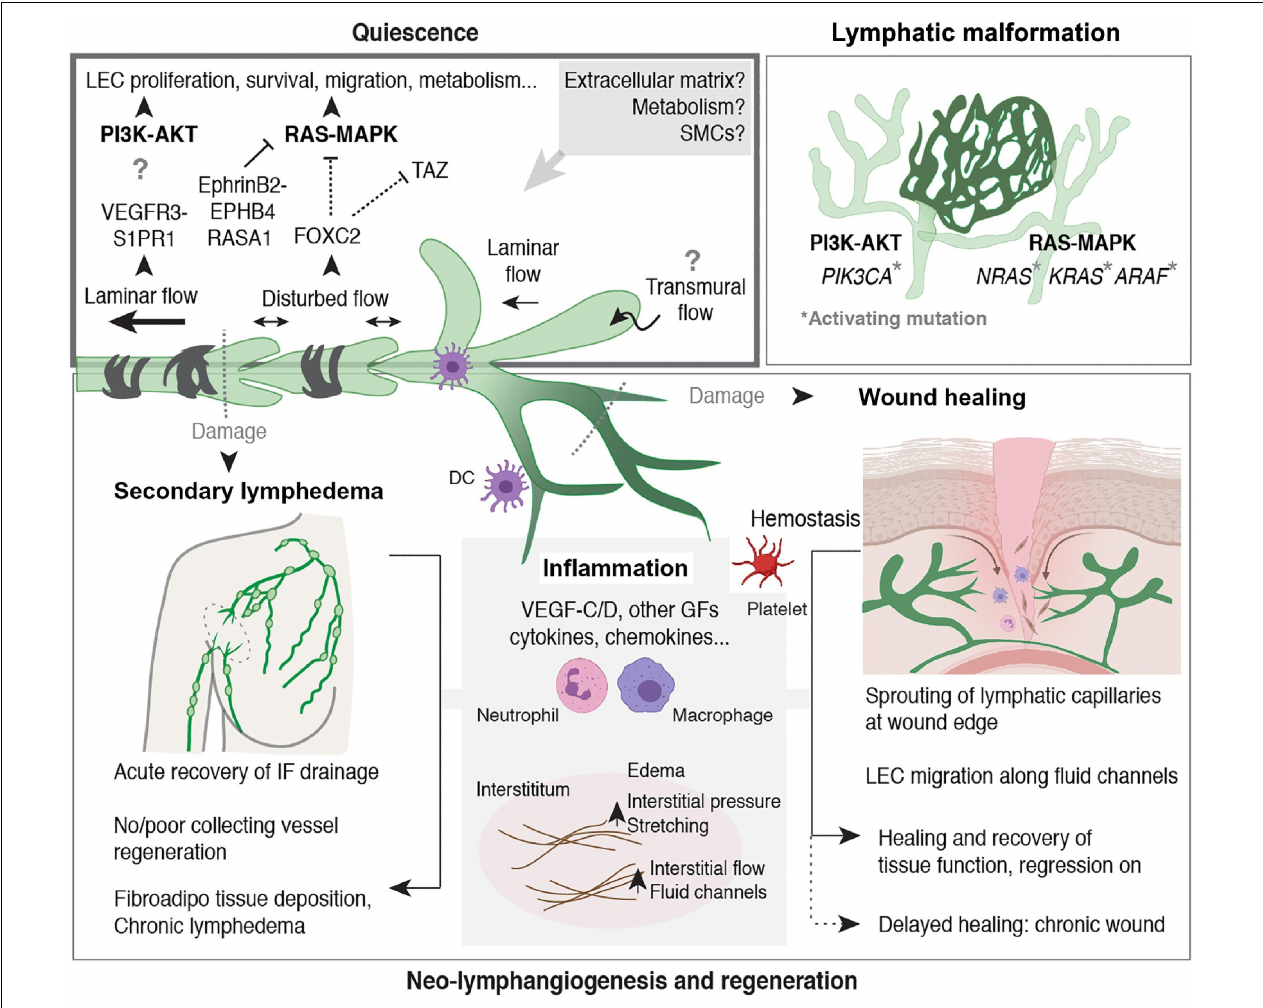
FIGURE 3 | Regulation of LV quiescence and growth in adults, reproduced from Stritt et al. (2021). Mechanisms that regulate the maintenance of LEC quiescence (upper left box) and the reactivation of LV growth and regeneration in adult tissues are depicted. Somatic activating mutations in genes encoding components of the major mitogenic phosphoinositide 3-kinase (PI3K) and rat sarcoma viral oncogene (RAS)–mitogen-activated protein kinase (MAPK) pathways cause lymphatic malformations (upper right box). Inflammation is a major driver of neo-lymphangiogenesis (in gray in the lower box). Processes associated with wounding and damage to lymphatic capillaries or collecting LVs are indicated (lower box). Figure created with the help of BioRender.com. Abbreviations: AKT, protein kinase B; ARAF, A-Raf proto-oncogene serine/threonine kinase; DC, dendritic cell; EPHB4, ephrin receptor B4; FOXC2, Forkhead box C2; GF, growth factor; IF, interstitial fluid; KRAS, Kirsten RAS; NRAS, neuroblastoma RAS; RASA1, Ras p21 protein activator 1; S1PR1, sphingosine 1-phosphate receptor 1; SMC, smooth muscle cell; TAZ, Tafazzin phospholipid-lysophospholipid transacetylase; VEGFR-3, vascular endothelial growth factor receptor